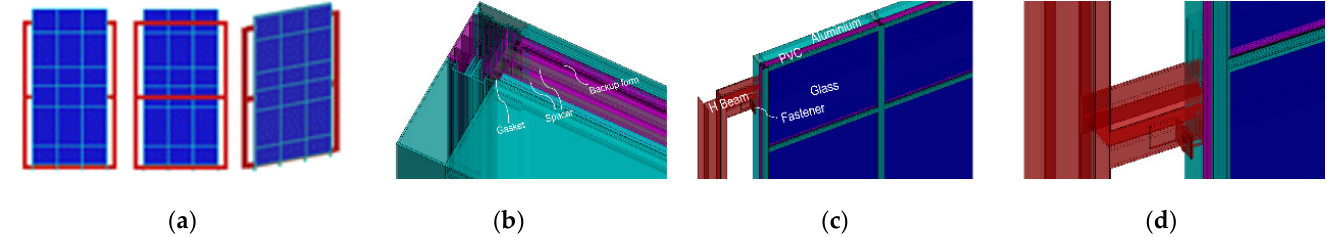
Figure 15. Details of full-frame FE model in solid form: ( a ) external shape of the FE model; ( b ) internal member detail; ( c ) chamber and aluminum frame; ( d ) anchor connection.